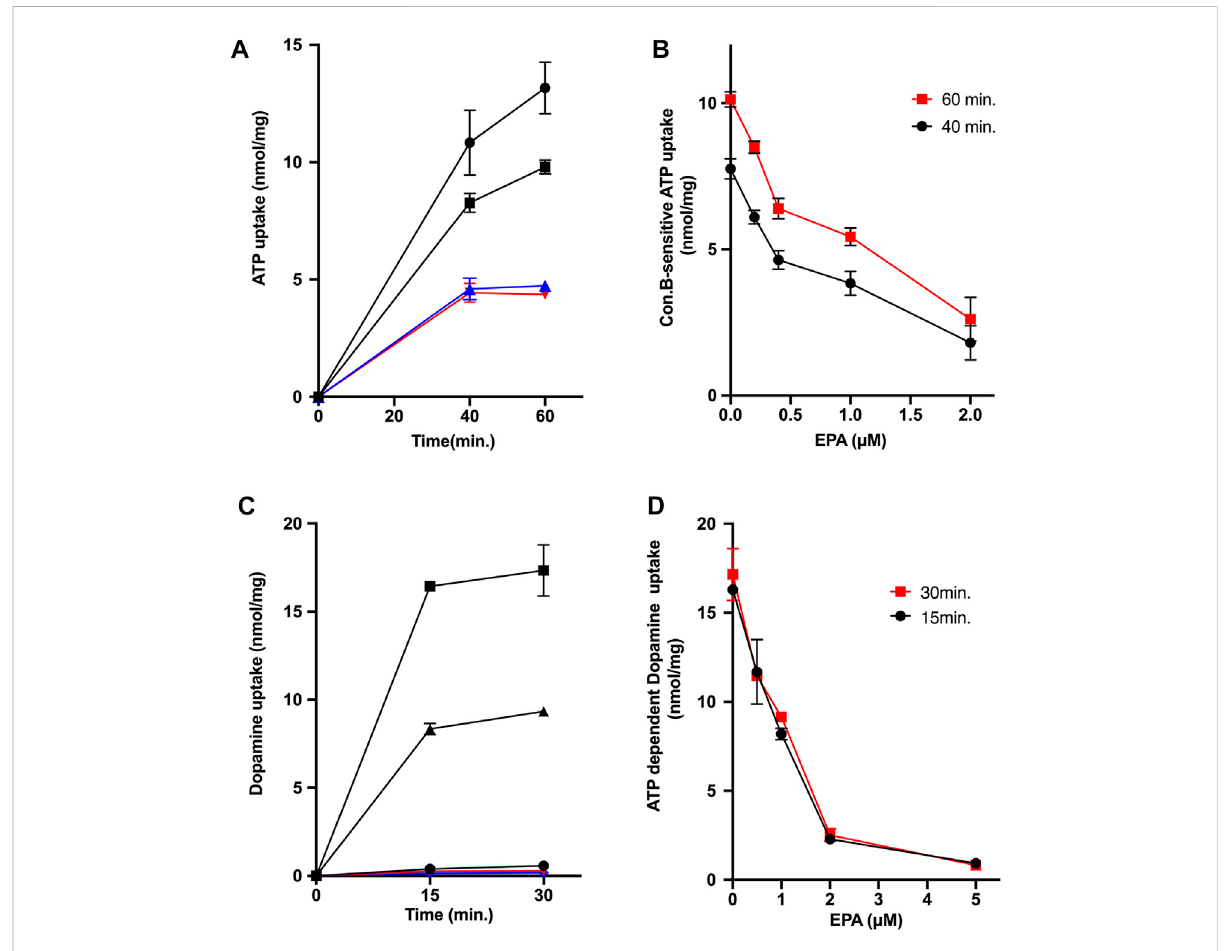
FIGURE 3 EPA inhibits uptakes of ATP and dopamine in chromaf fi n granule membrane vesicles. (A,B) Effect of EPA on the ATP-dependent ATP uptake by chromaf fi n granule membrane vesicles. (A) indicates the time course of ATP uptake. Assays were performed in the absence ( ) or presence of EPA, 1 μ M ( ), con B, 1 μ M ( ), or CCCP 1 μ M ( ). (B) indicates the EPA dose dependence. ATP uptake was assayed as in Figure 3 in the presence or absence of the listed concentration of EPA. The amount of ATP uptake in the presence of con B at 1 μ M at either 40 min or 60 min